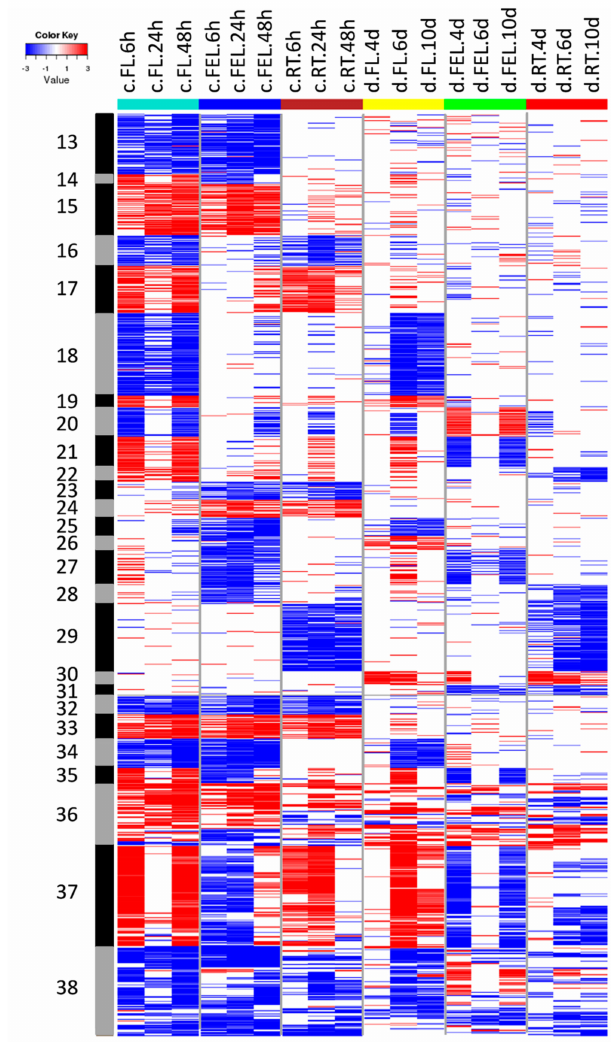
Figure 4. Heatmap of DE genes significantly changed in at least two tissues responding to cold and/or drought stresses. In total, 26 groups of genes were identified. Blue represents down-regulation, and red represents up-regulation. Samples were named by combination of stresses (“c” for cold, and “d” for drought), tissues, and time points as indicated in Figure